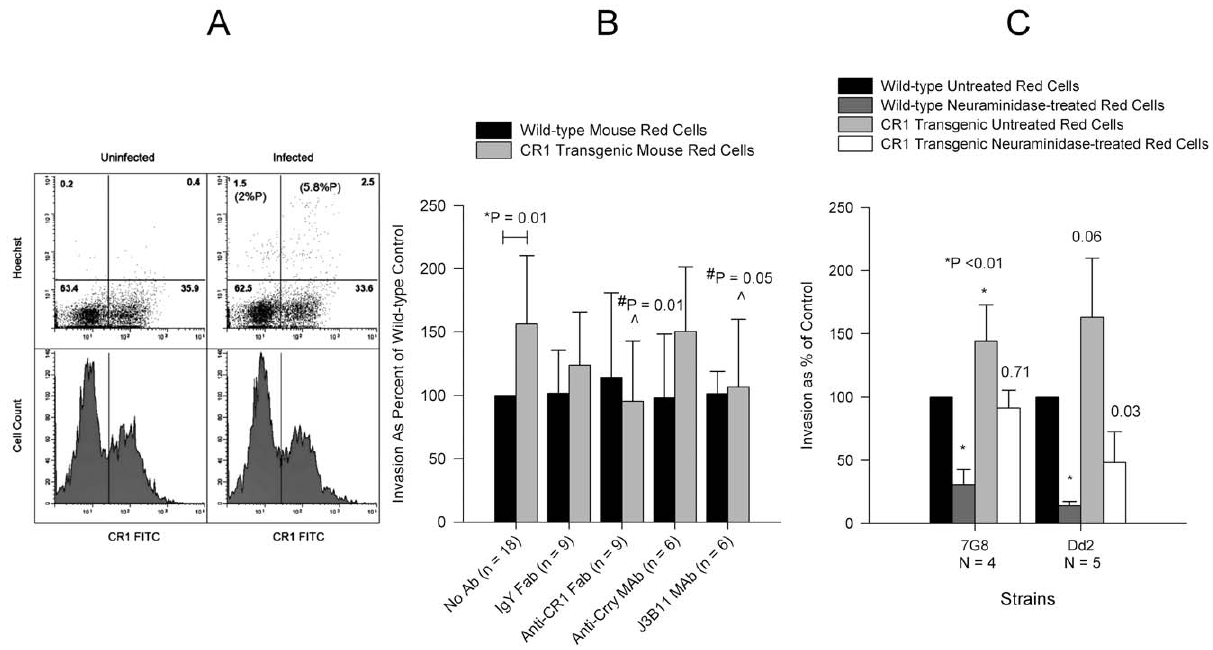
Figure 8. Invasion of wild-type and human CR1 transgenic mouse erythrocytes by P.falciparum . (A) 7G8 invaded CR1 transgenic mouse erythrocytes preferentially in a mixed culture of wild-type and CR1 transgenic mouse erythrocytes incubated overnight with or without schizonts and analysed by flow cytometry. Upper panels show dot plots of Hoechst negative (uninfected) and positive (infected) erythrocytes. Numbers in parenthesis represent the percent parasitemia (%P). Numbers without parenthesis in each quadrant represent the percent cells from the total population. The lower panels show CR1 fluorescence histograms and the demarcation between CR1 positive (rectangle) and negative erythrocytes. (B) Effect of polyclonal and monoclonal antibodies on the invasion of wild-type and CR1 transgenic mouse erythrocytes by 7G8. Only significant P values are shown. *P is for the comparison between wild-type and CR1 transgenic red cells with no antibody. # P is for the comparison between antibody and no antibody. Invasion in wild-type erythrocytes ranged from 0.2% to 4.5%. (C) Comparison of invasion of wild-type and CR1 transgenic mouse erythrocytes between 7G8 and Dd2. Numbers above bars represent P values for the comparison to the wild-type untreated control. Invasion was measured by flow cytometry and ranged from 0.45% to 5.5% in wild-type untreated erythrocytes. All bars represent means 6 standard deviations.